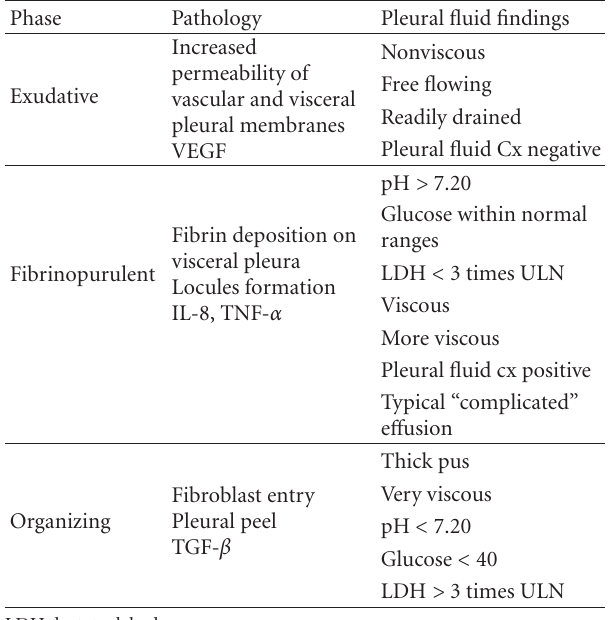
Table 2: Di ff erent stages in the evolution of an infected pleural e ff usion with associated pathological changes and pleural fluid